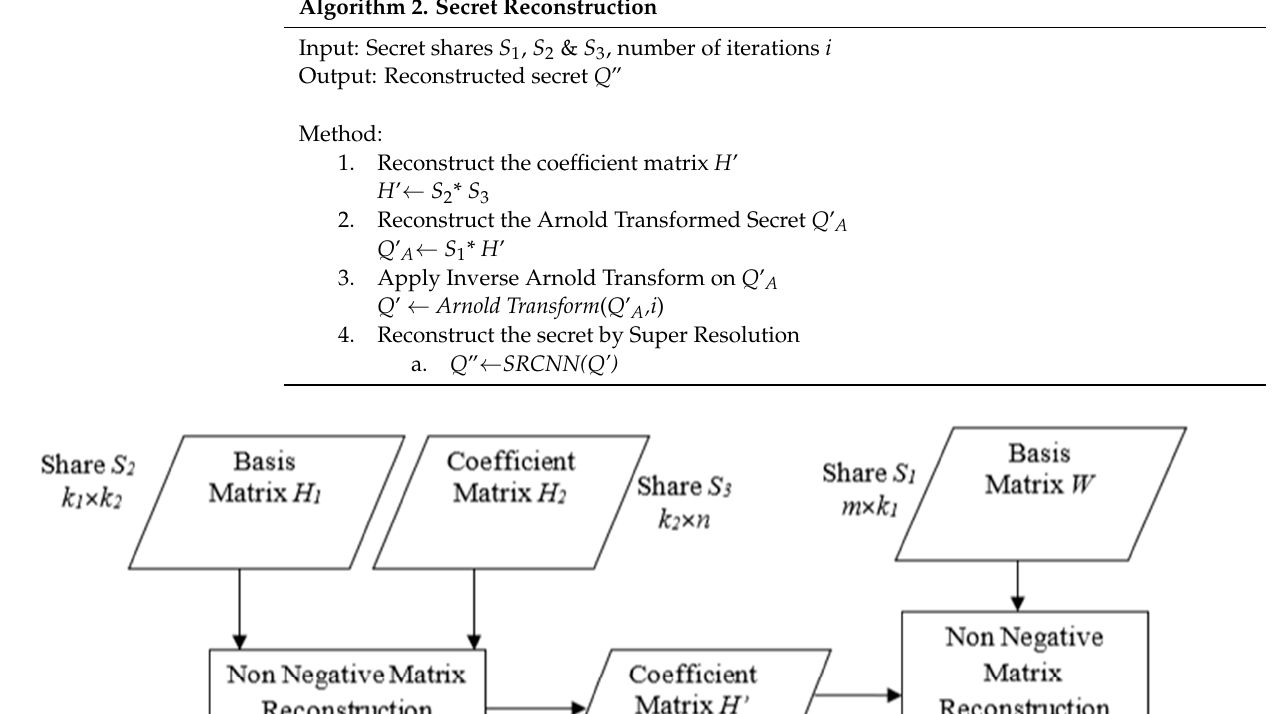
Algorithm 2. Secret Reconstruction